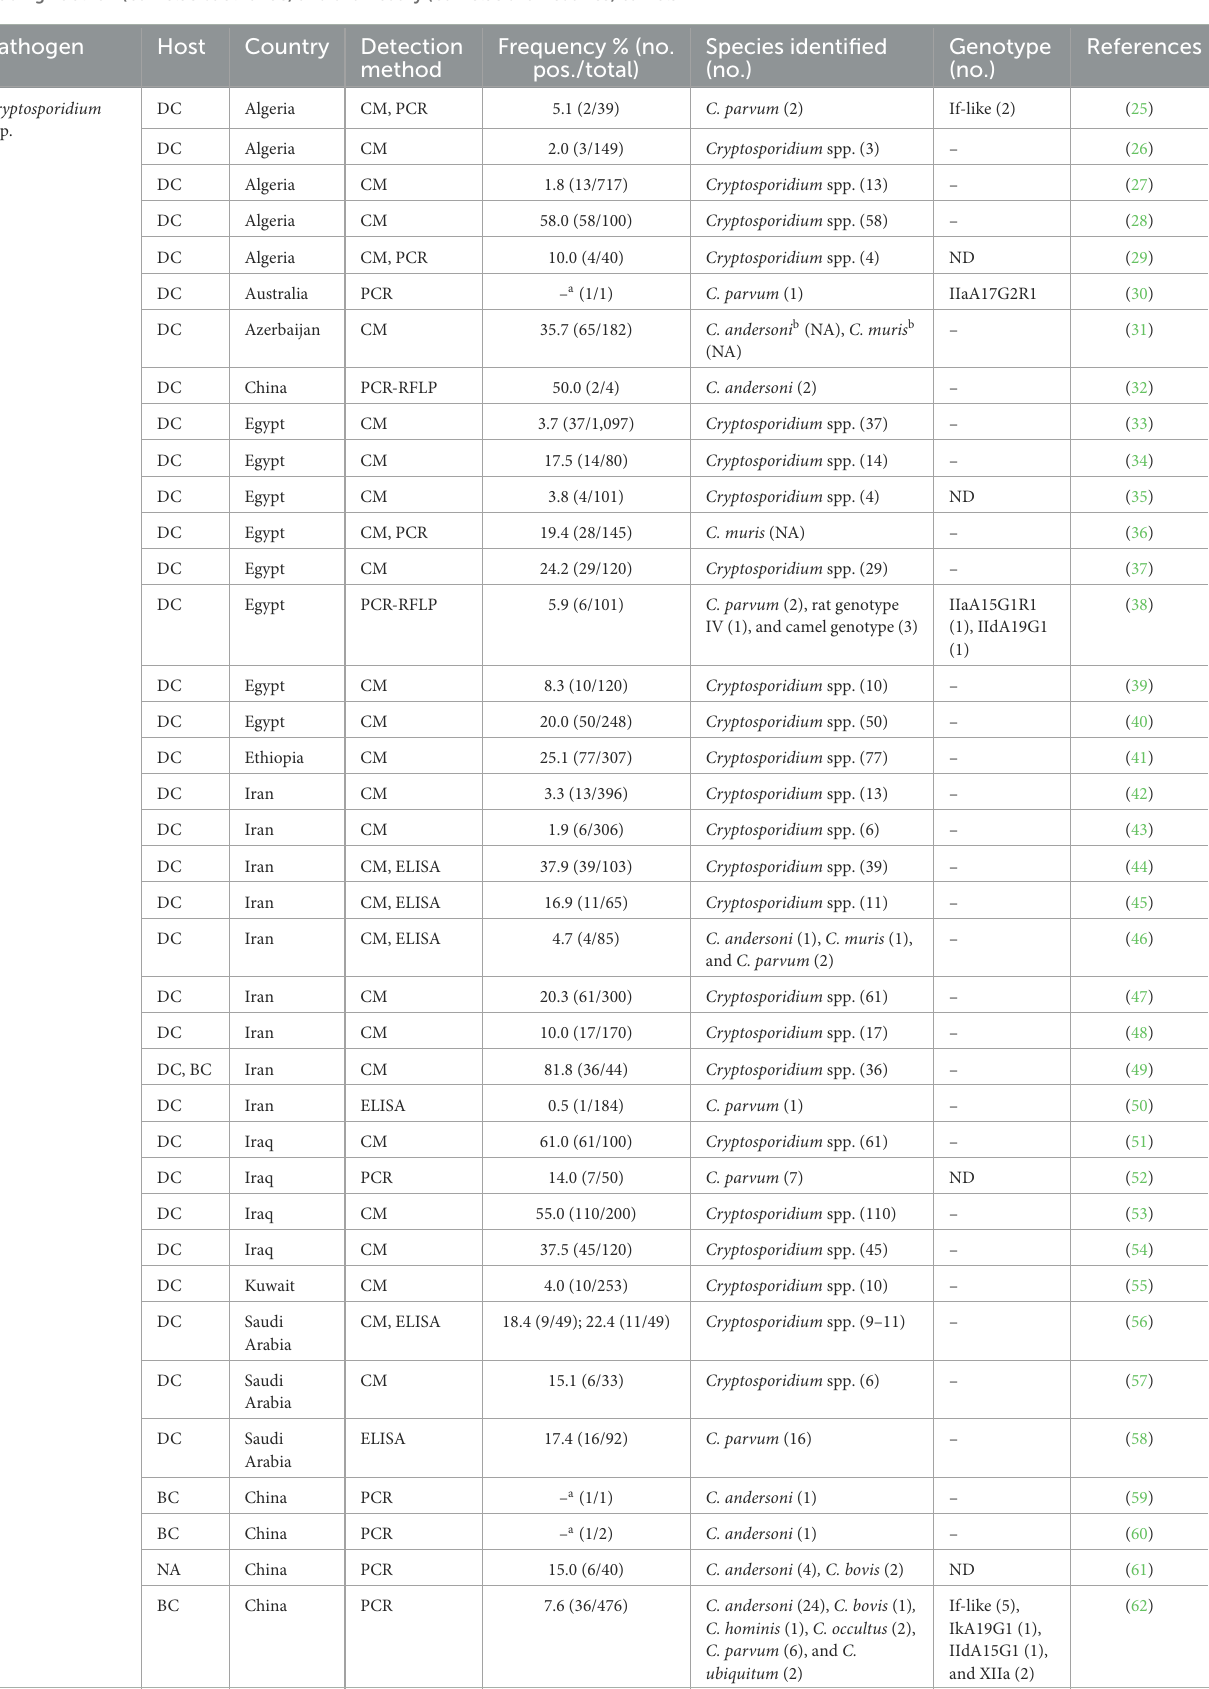
Frequency % (no. Species identified Genotype method pos./total) (no.) (no.)